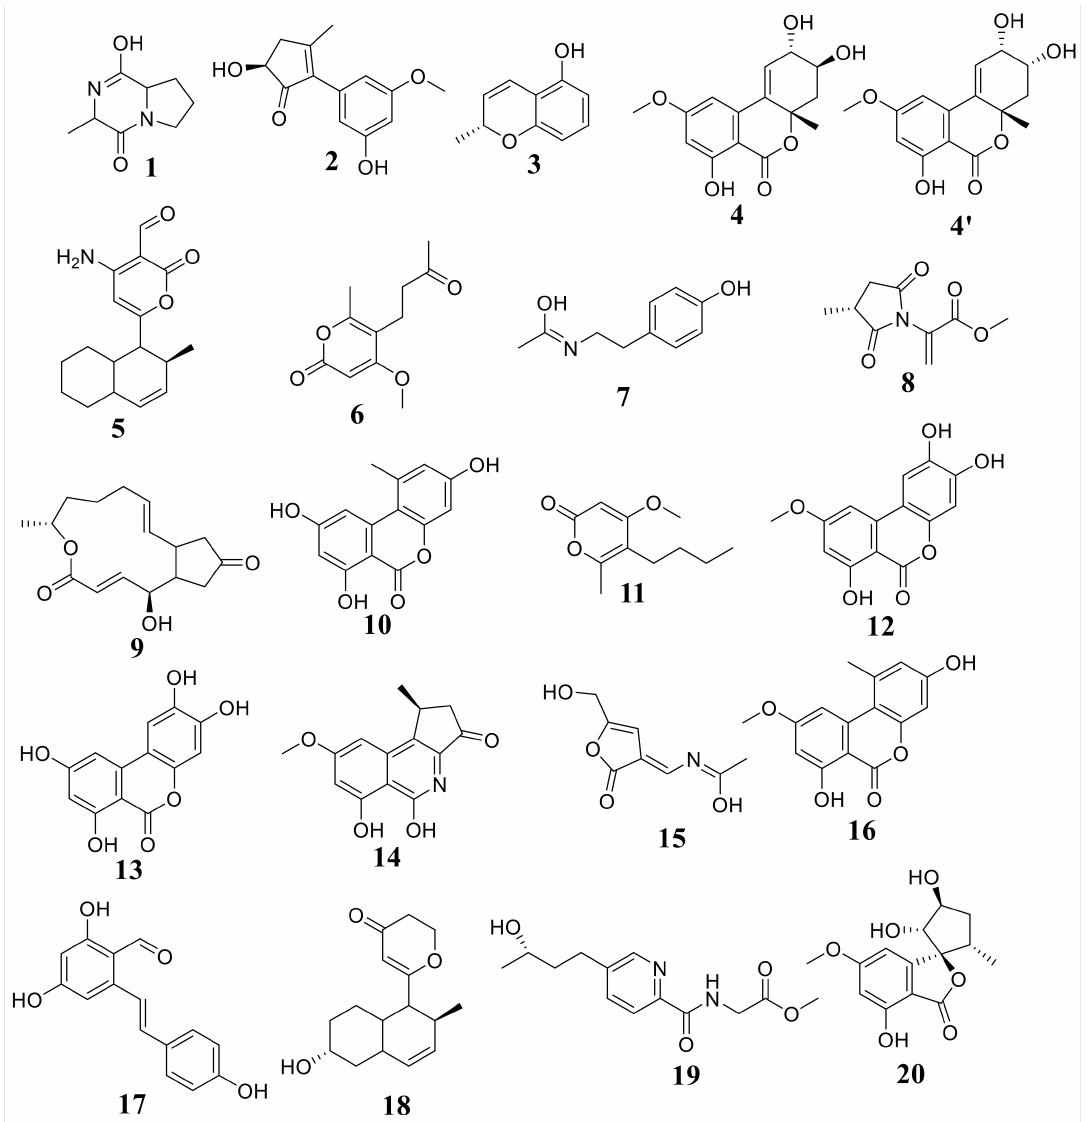
Figure 7. Chemical structures of detected compounds in A. tenuissima EtOAc